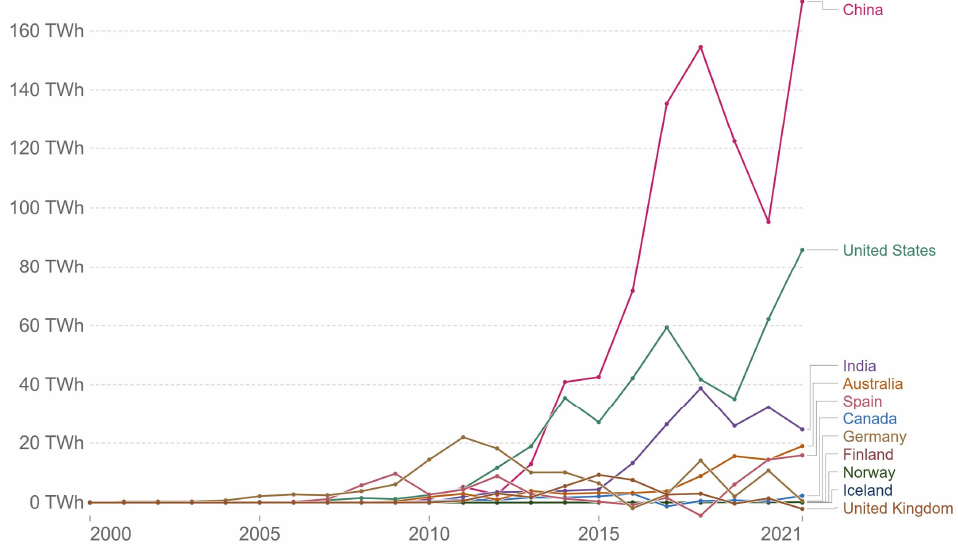
Figure 8. Annual change in solar energy generation across different country [41].